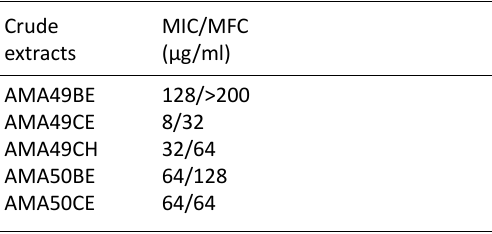
Table 2. Antifungal activity against P. oryzae PTRC1 of five active crude extracts from marine-derived actinobacteria strains AMA49 and AMA50